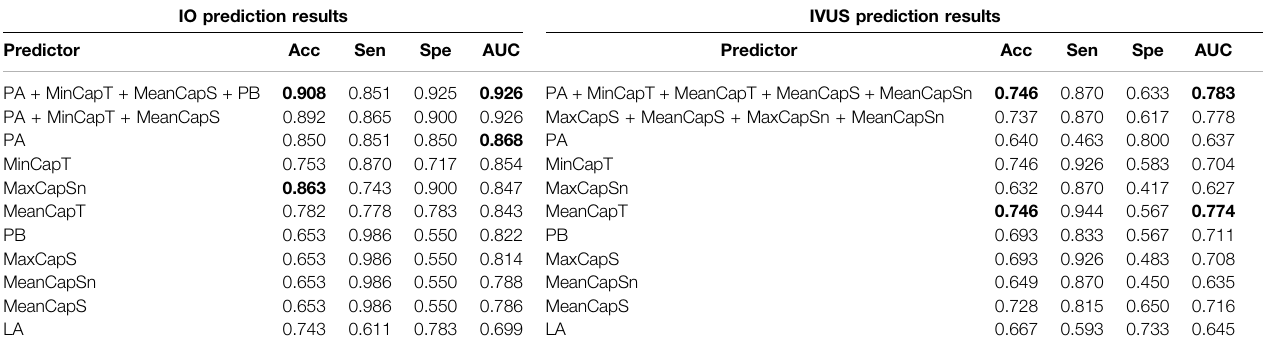
TABLE 5 | Δ MinCapT prediction results using the GLMM method. AUC: area under the ROC curve; Acc: accuracy; Sen: sensitivity; Spe: speci fi city. Bold indicates the best value. IO prediction